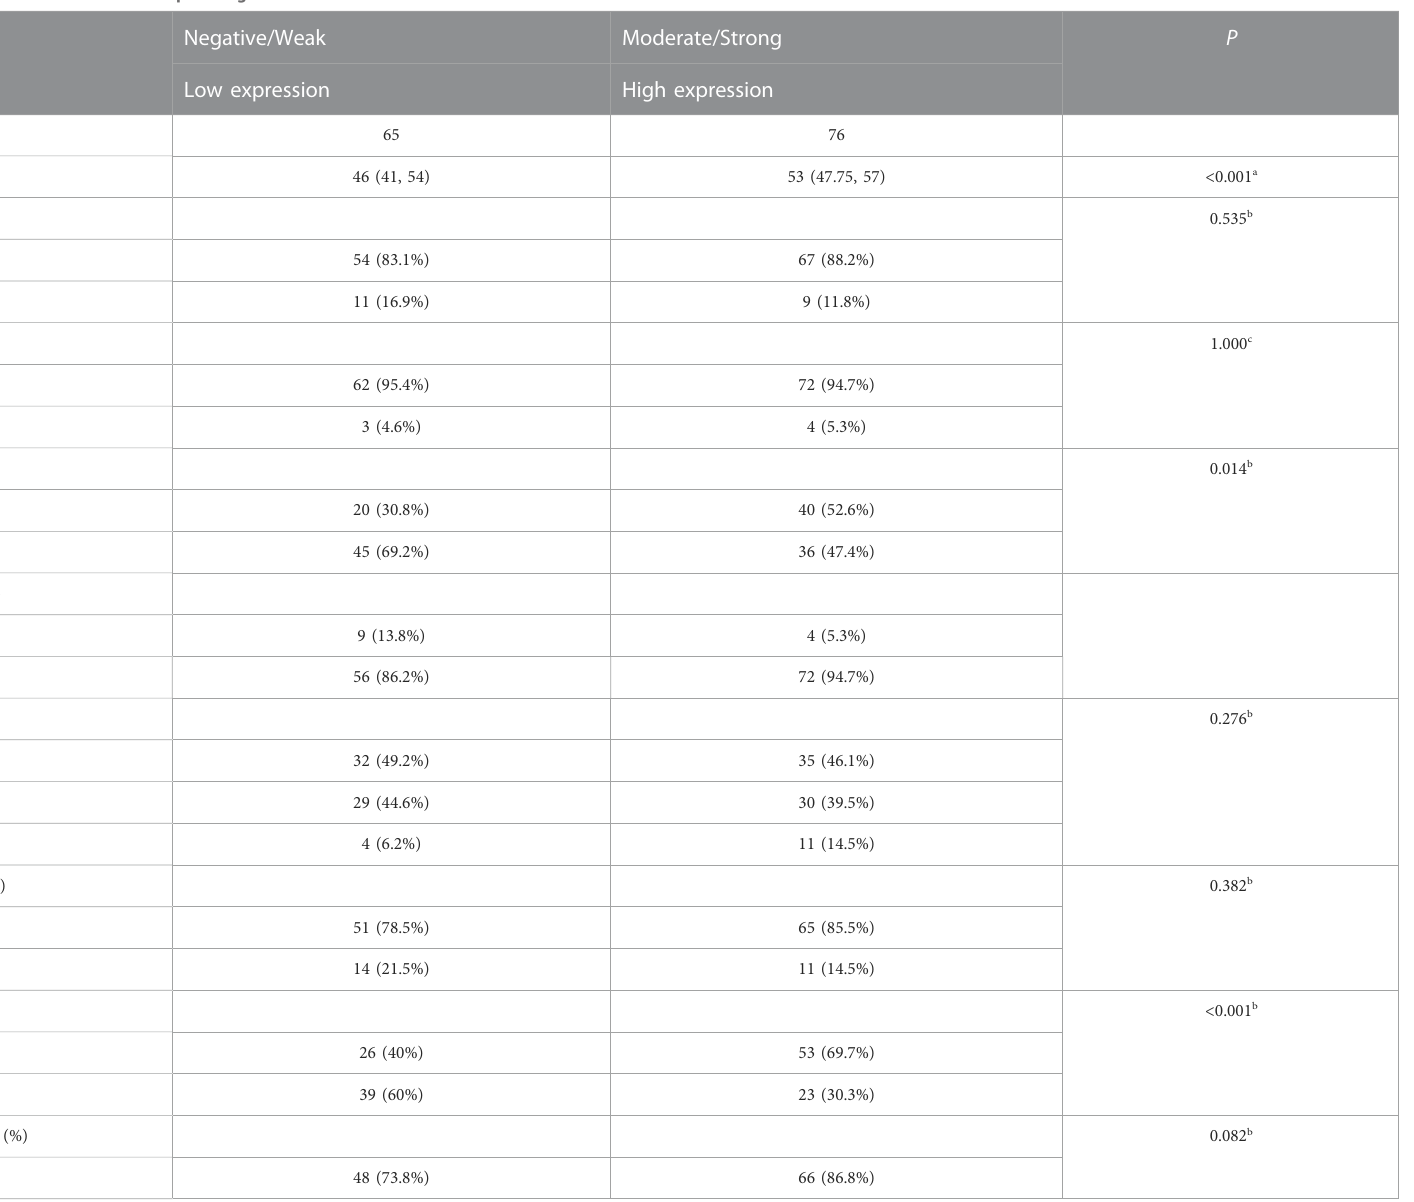
TABLE 1 KLF4 expression in 141 HCC patients based on clinicopathologic